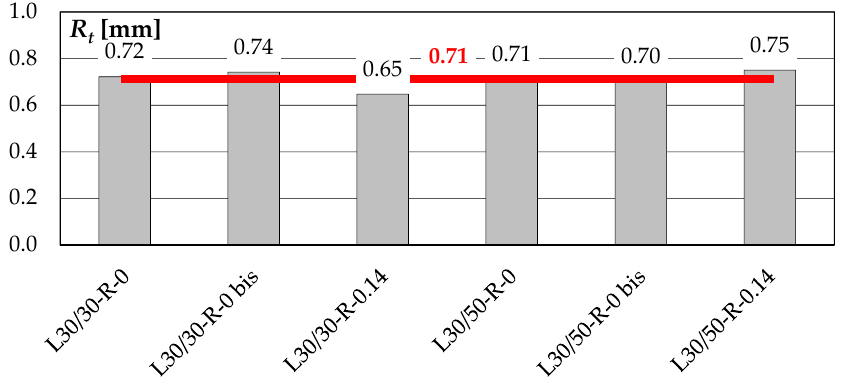
Figure 7. Roughness of the interface surface of the test specimens.